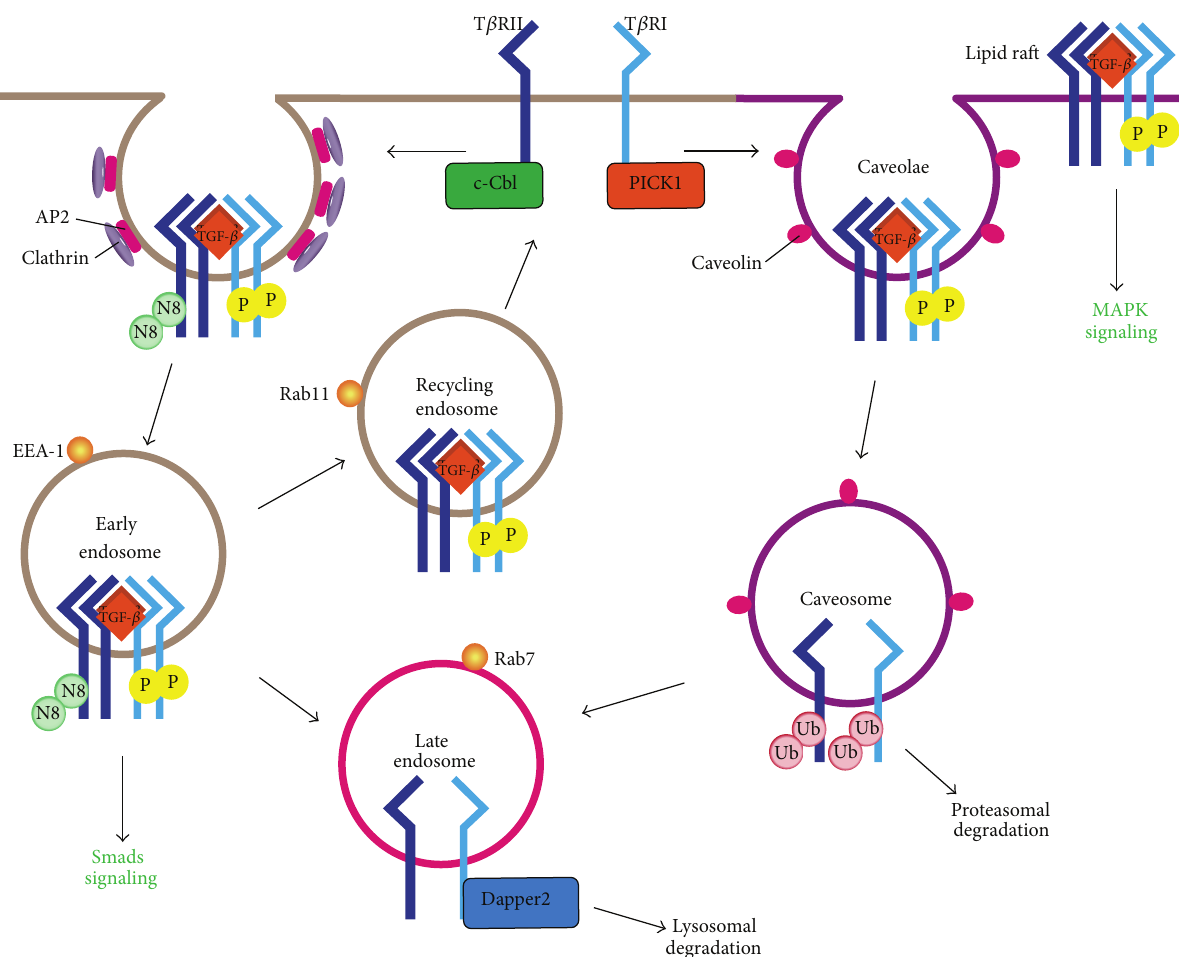
Figure 1: Membrane trafficking regulates the activity and stability of TGF- 𝛽 receptors. Internalization of TGF- 𝛽 receptors through clathrin-dependent endocytosis enhances TGF- 𝛽 -Smad signaling, whereas caveolin-mediated endocytosis promotes the ubiquitination and degradation of the receptors and thus the turnoff of signaling. c-Cbl neddylates T 𝛽 RII and facilitates its clathrin-dependent endocytosis, while PICK1 promotes lipid raft/caveolae localization and caveolin-mediated endocytosis of T 𝛽 RI. Dapper2 locates in late endosomes and accelerates the lysosomal degradation of T 𝛽 RI. The lipid raft localization of TGF- 𝛽 receptors is critical for TGF- 𝛽 -mediated MAPK